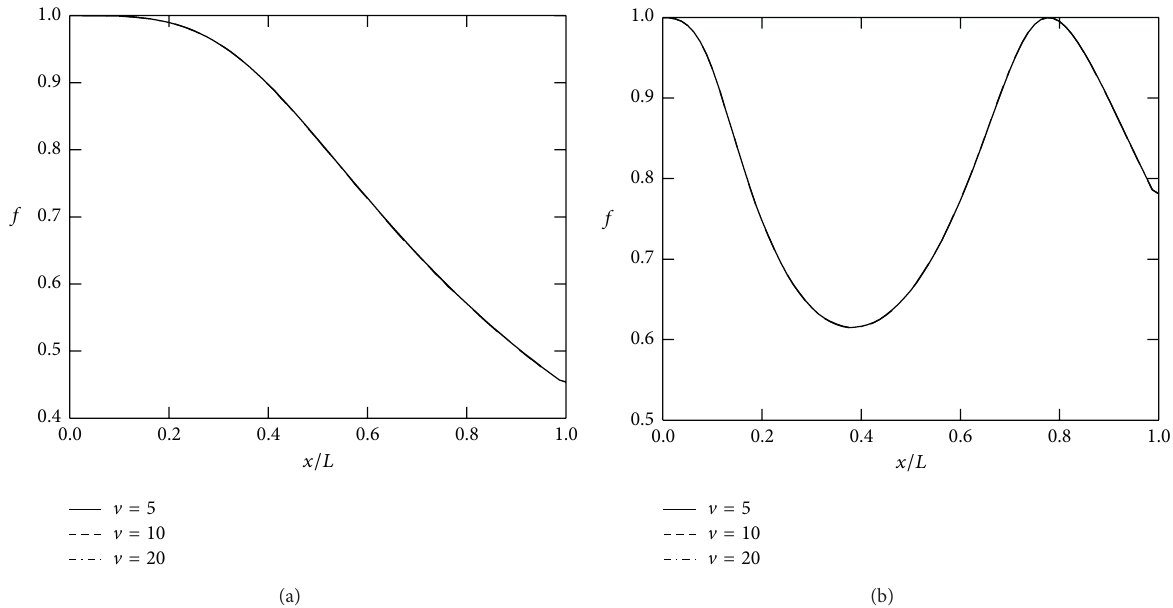
Figure 5: The first two normalized natural frequencies of clamped-free Timoshenko beam subjected to a moving mass with different velocities.